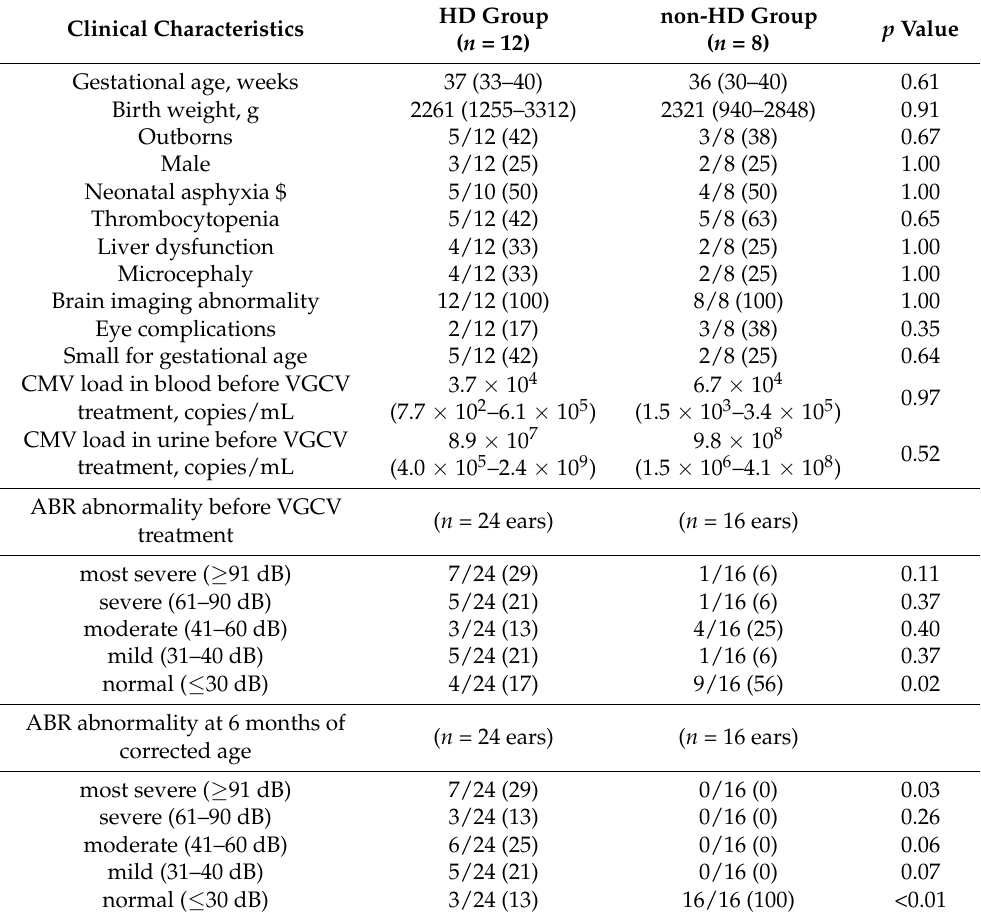
Table 1. Clinical characteristics of infants with and without CCMVI diagnoses confirmed by PCR. Clinical